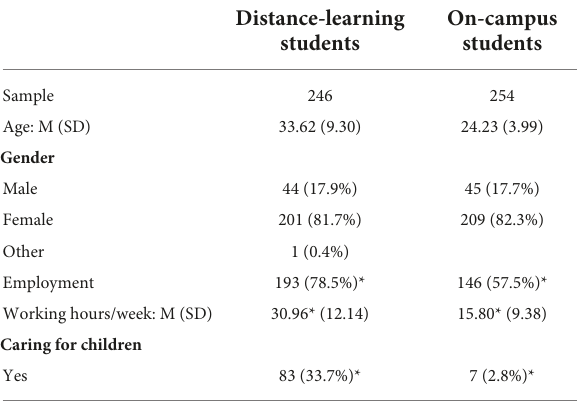
TABLE 1 Sociodemographic characteristics of the study sample ( N =